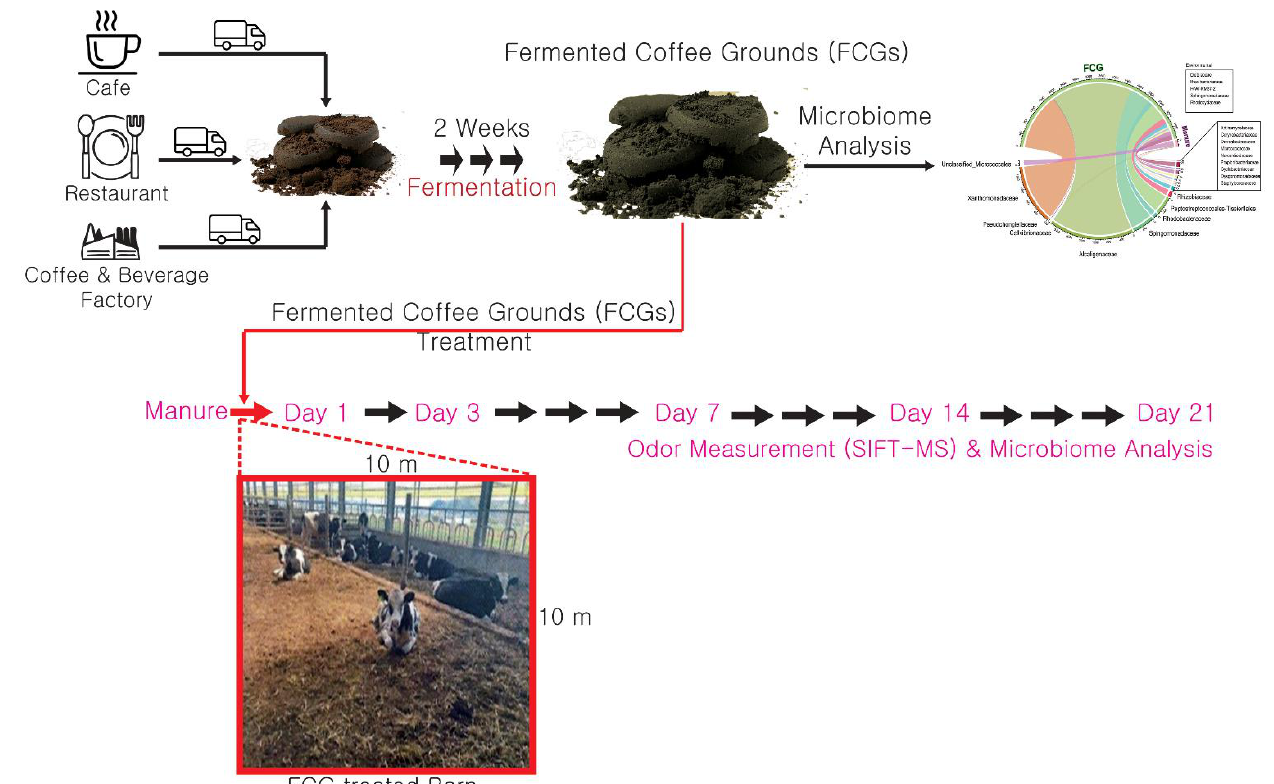
Figure 1. The experimental scheme. The steps of the experiment are illustrated.